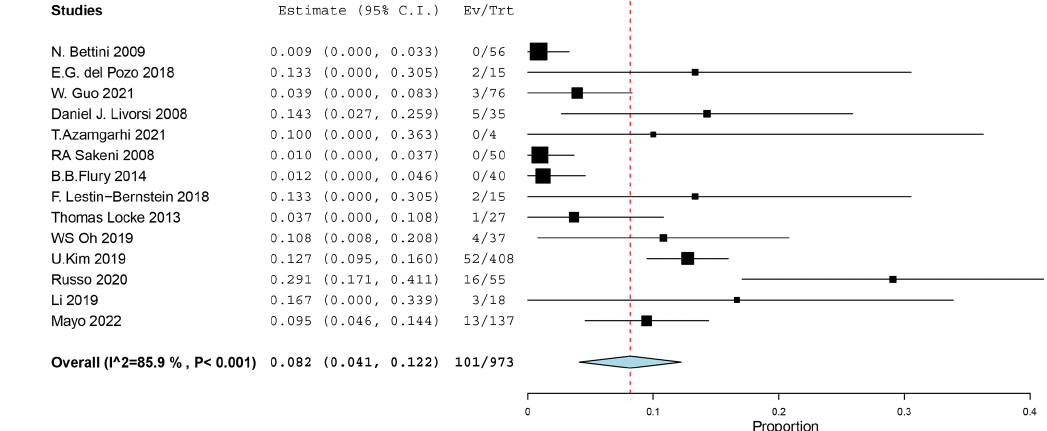
Figure 3. Proportion of patients with failure and relapse among all the studies including a non-early switch (Ev, events; Trt, group of treated patients with non-early